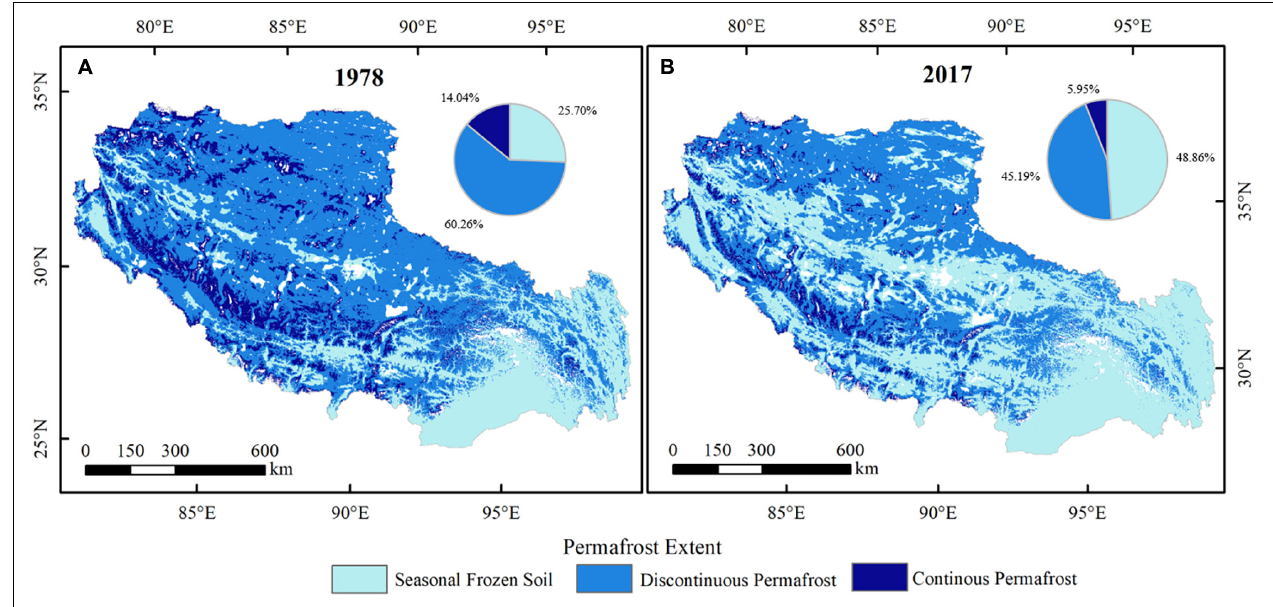
FIGURE 5 | (A) Simulated previous and (B) current extent of permafrost for 1978 and 2017, respectively. Note that the white areas are lake and glacier.